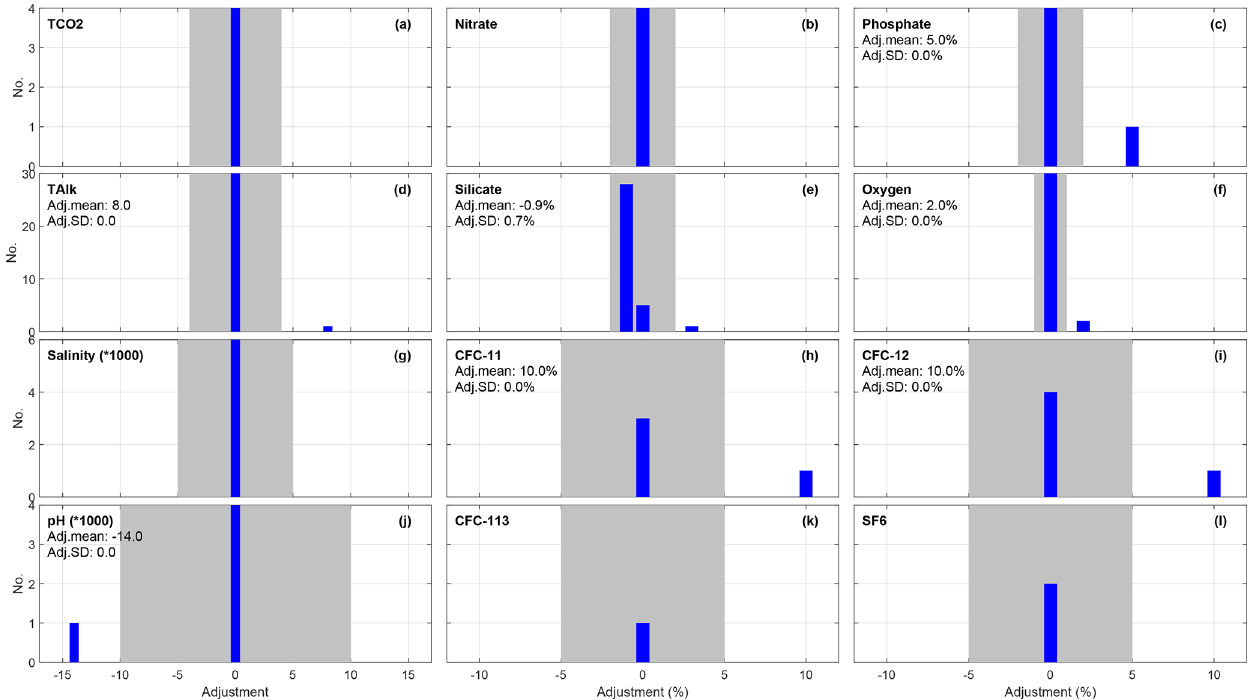
Figure 7. Distribution of applied adjustments for each core variable that received secondary QC, in micromoles per kilogram (µmolkg − 1 ) for TCO 2 and TAlk and unitless for salinity and pH (but multiplied by 1000 in both cases so a common x axis can be used), while for the other properties adjustments are given in percent ((adjustment ratio − 1) × 100). Grey areas depict the initial minimum adjustment limits. The figure includes numbers for data subjected to secondary quality control only. Note also that the y -axis scale is set to render the number of adjustments visible, so the bar showing zero offset (the 0bar) for each variable is cut off (see Table 6 for these numbers).